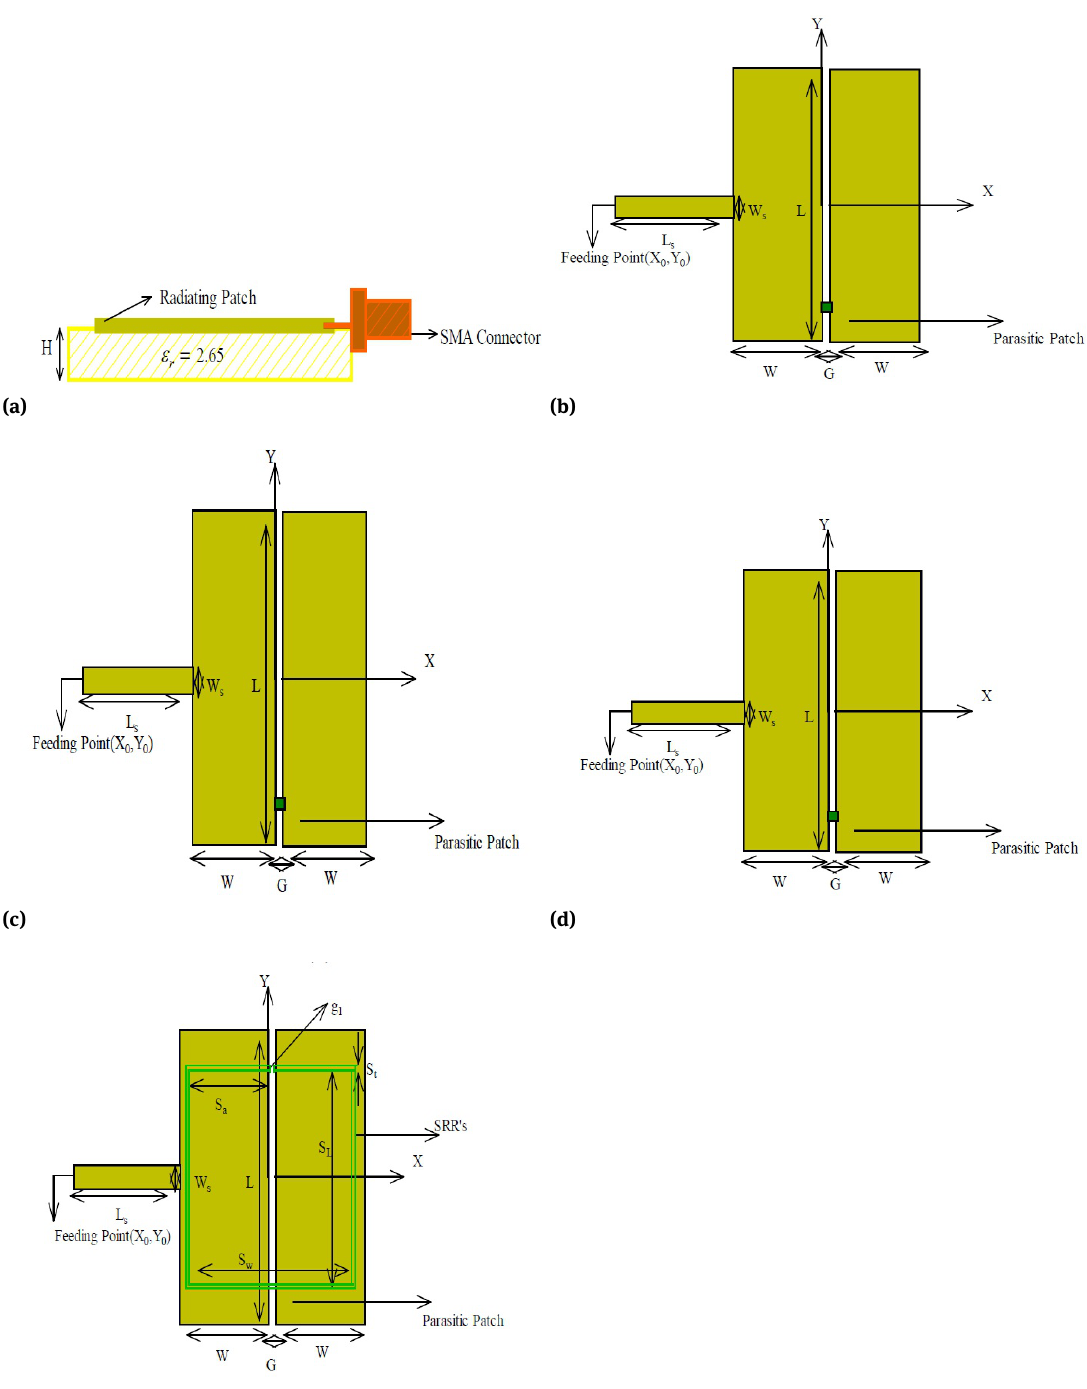
Figure 1: (a)Side view microstrip line fed patch antennas(b) Simple microstrip line fed patch (antenna 1), (c) microstrip line fed patch with parasitic element (antenna 2),(d) Top View and (e) Bottom View of proposed microstrip line fed patch antenna (antenna